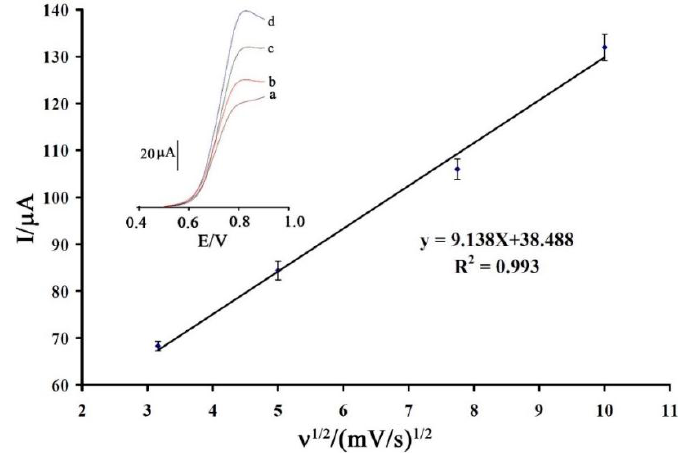
Figure 4. Plot of I pa vs. ν 1/2 for the oxidation of vitamin B 9 at 1,3-DIBr/ZnO/CNTs/CPE. Inset shows linear sweep voltammograms of vitamin B 9 at 1,3-DIBr/ZnO/CNTs/CPE at different scan rates of ( a ) 10; ( b ) 25; ( c ) 60 and ( d ) 100 mV/s in 0.1 M phosphate buffer, pH 9.0.